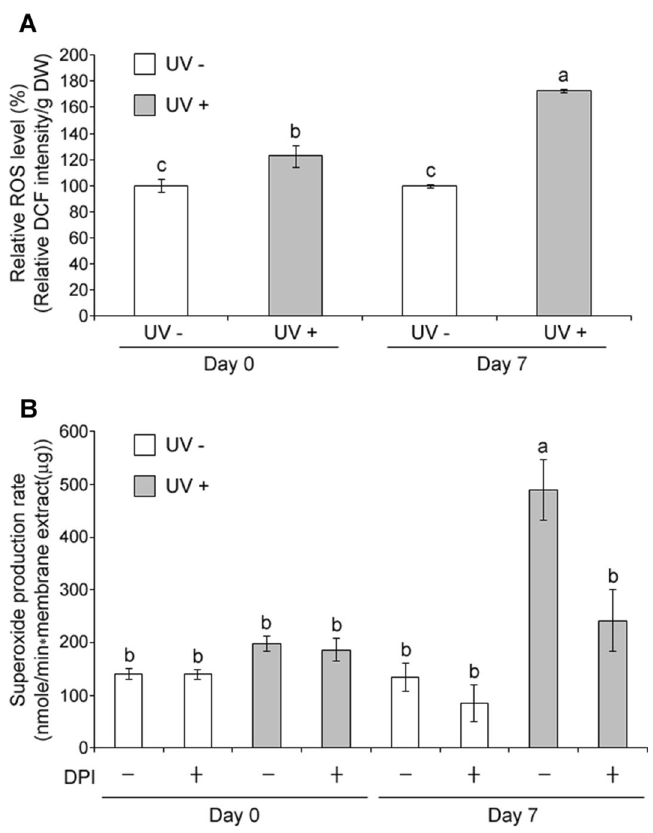
to ROS measurement ( A ) and NOX assay ( B ). The 350 µM DPI in ( B ) was used as a NOX inhibitor to confirm that the superoxide was generated from NOX. Data, obtained from at least three biological repeats, are shown as mean ± SE values. Different letters indicate significant differences by the ANOVA/Tukey-HSD ( p < 0.05).